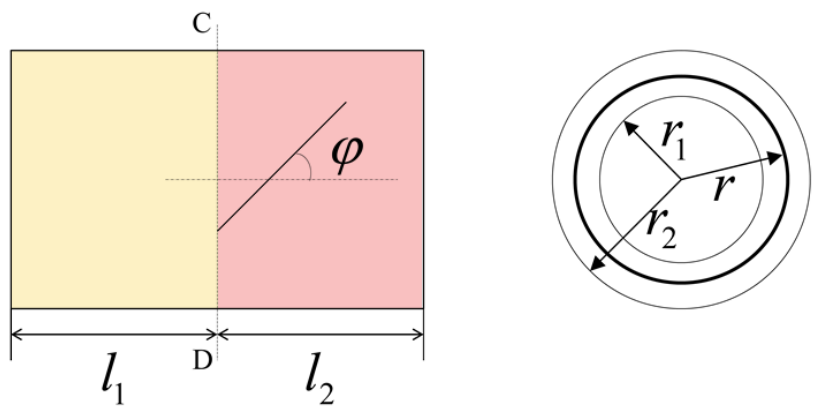
Figure 5. Front cover plate of longitudinal – torsional transducer.